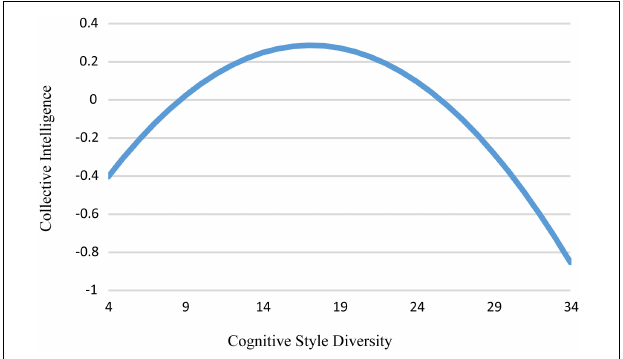
FIGURE 2 | The relationship between cognitive style diversity and collective intelligence controlling for team size and cognitive style level.